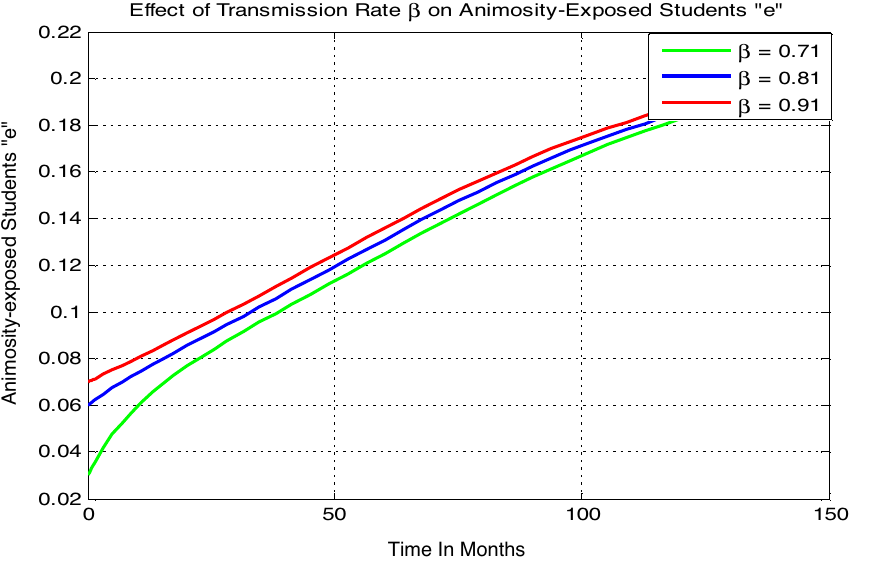
Figure 4. Effect of transmission rate β on animosity-exposed